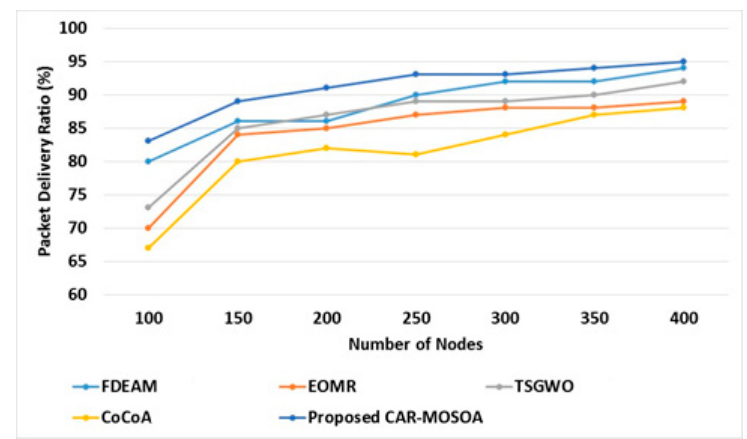
Figure 6. Performance based on packet delivery ratio.